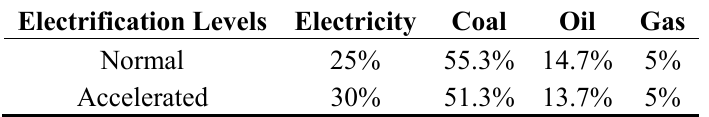
Table 3. Shares of different energy forms in industrial demand by